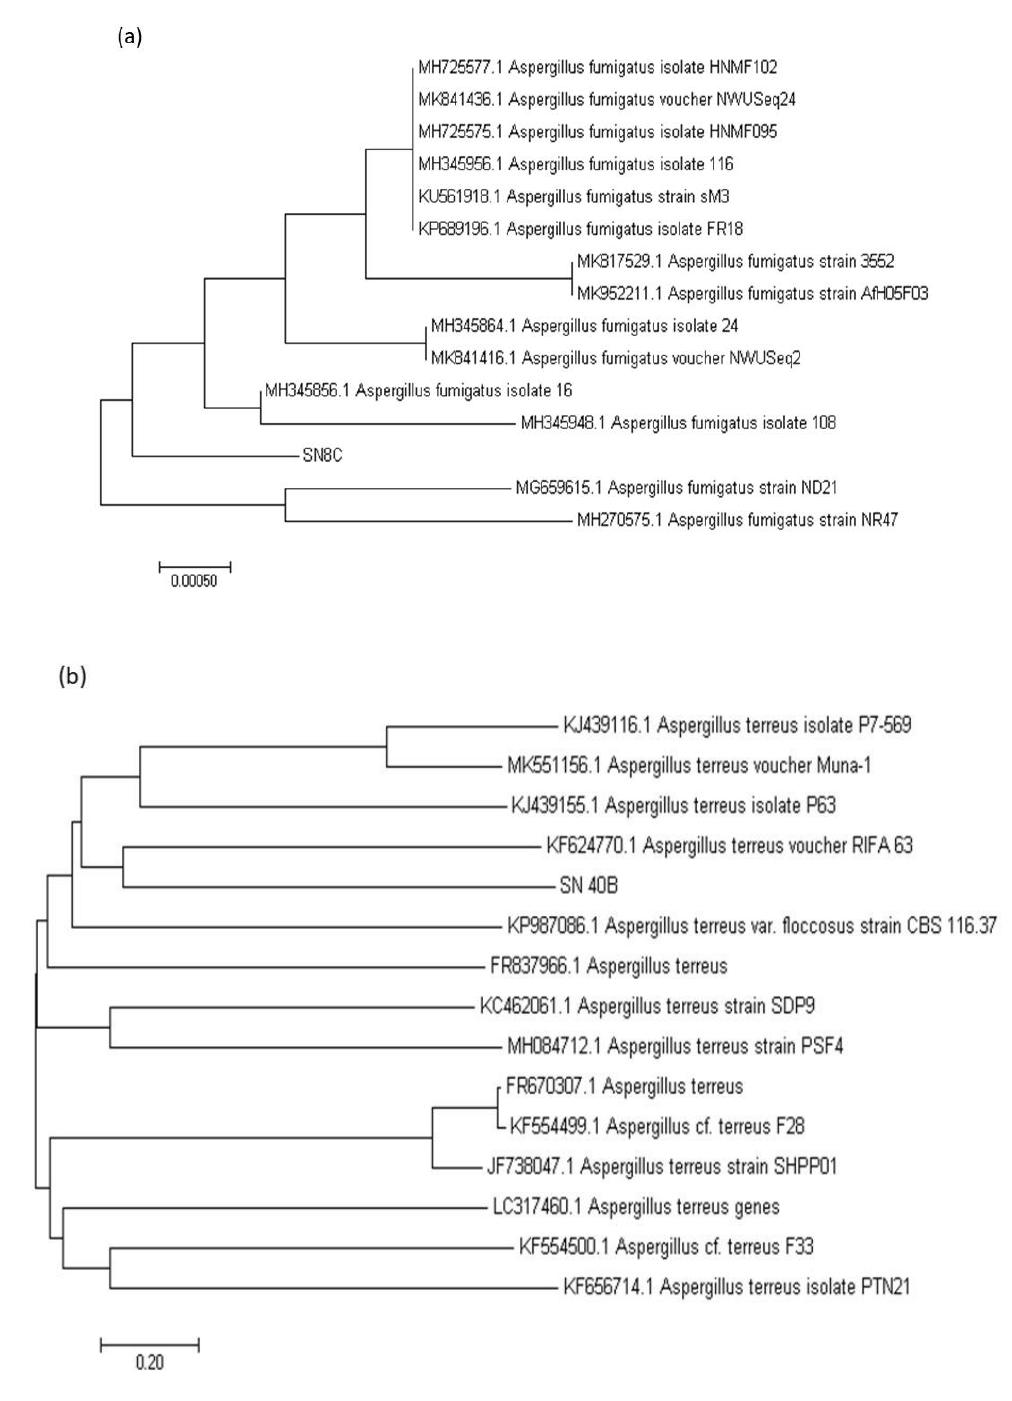
Figure 10. ( a , b ) Phylogenetic tree constructed through the maximum parsimony method using MEGA 6.0 [37]. The sequence obtained from ITS regions of rDNA of isolated fungi were making good clads with fungi sequences from BLAST. ( a ) The phylogenetic tree of SN8c identified as A. fumigatus , and ( b ) the phylogenetic tree of SN40b identified as A. terreus.